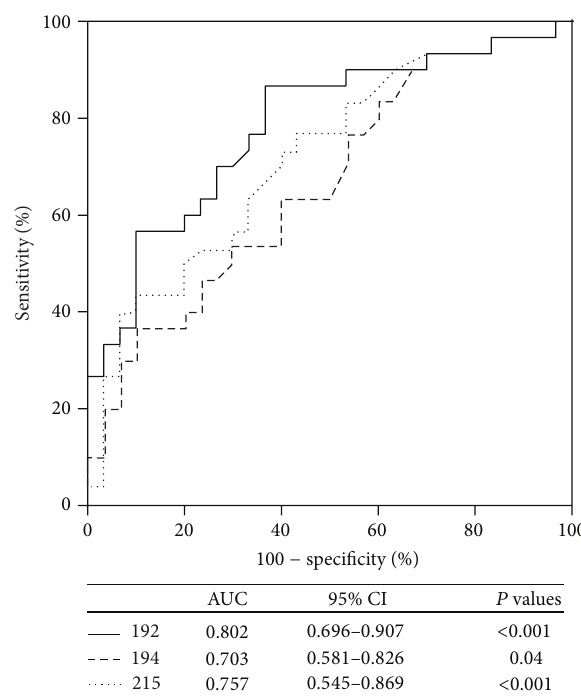
Figure 3: ROC analysis for miRNAs in patients with normoalbu- minuria and microalbuminuria (AUC = 0.802, 𝑃 < 0.001 for miR- 192; AUC = 0.703, 𝑃 = 0.04 for miR-194; and AUC = 0.757, 𝑃 < 0.001 for